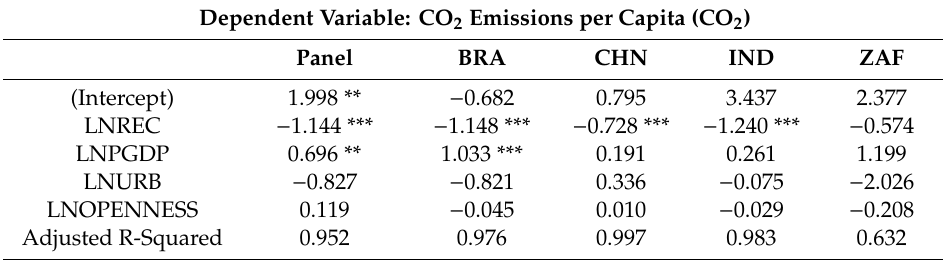
Table 9. Estimation results of GDP and renewable energy consumption on CO 2 emission (3SLS). Dependent Variable: CO 2 Emissions per Capita (CO 2 ) Panel BRA CHN IND ZAF